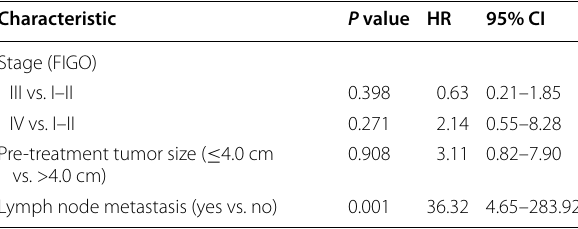
Table 3 Multivariate analysis results for overall survival rate of cervical cancer patients using the Cox multiple regression method